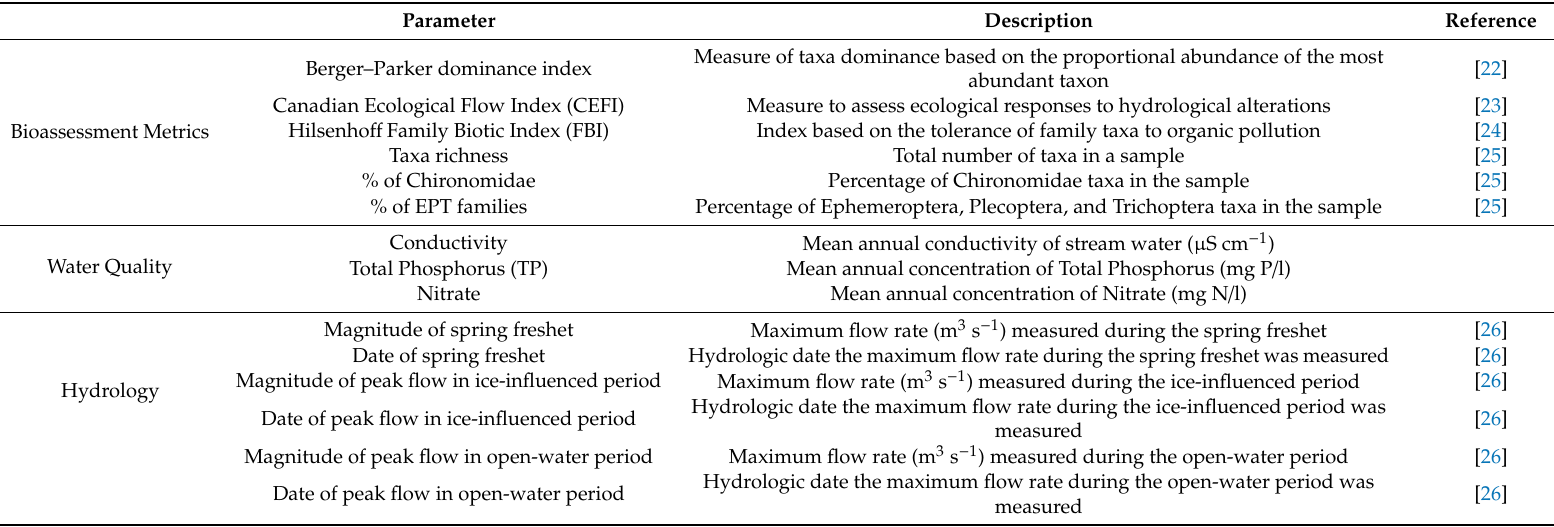
Table 3. List and description of bioassessment metrics as well as hydrologic and water quality parameters computed from monitoring data collected over at least 14 years from eight streams of the Upper Thames River Basin, southern Ontario,